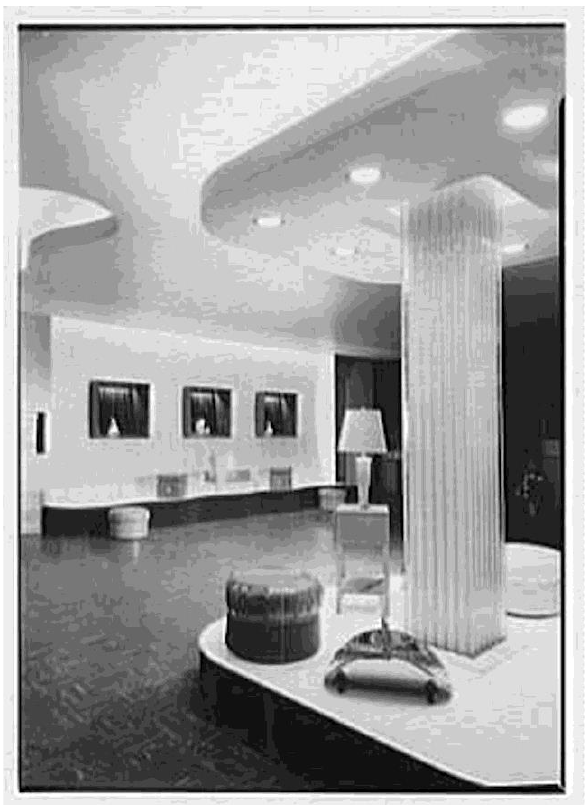
Figure 21. Hurley-Tobin, Trenton, New Jersey, 1947. Source: Gottscho-Schleisner Collection (Library of Congress). https://lccn.loc.gov/2018747188, (accessed on 1 June 2021).